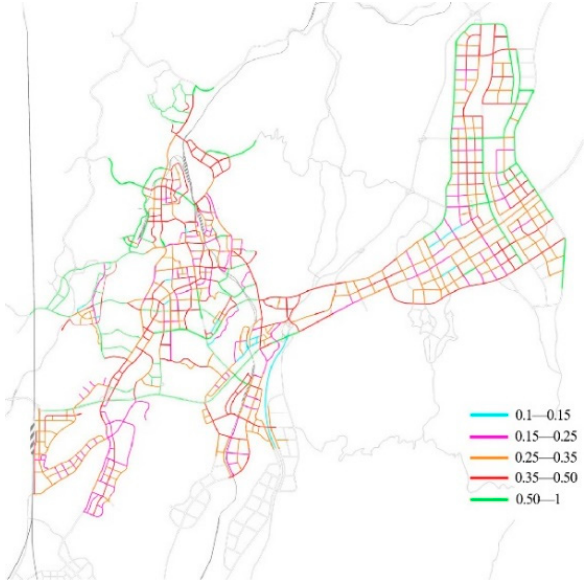
Figure 1. SVF values of main streets in Chenzhou city.